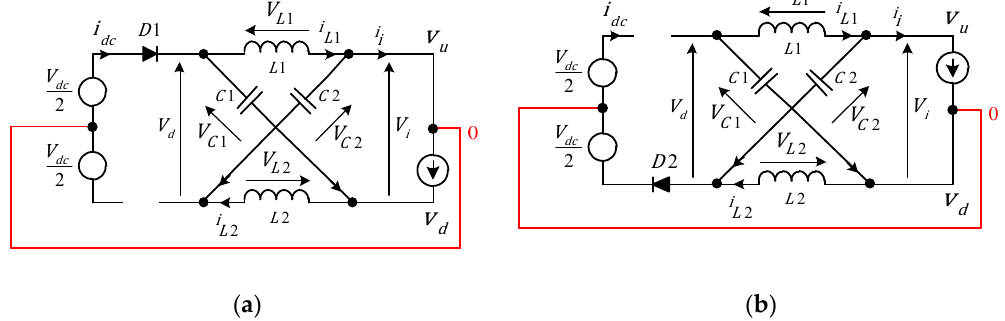
Figure 7. Simplified equivalent circuit for evaluating conditions: ( a ) Up shoot-through (UST); ( b ) down shoot-through (DST).